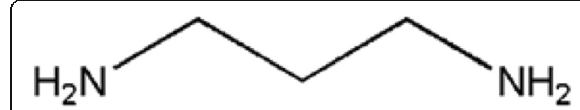
Fig. 4 Structure of